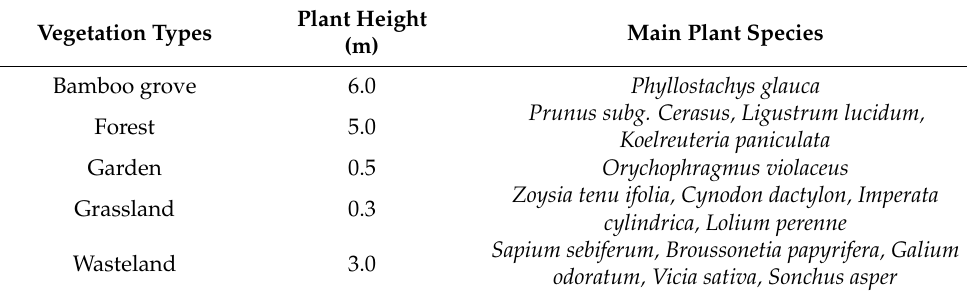
Main Plant Species